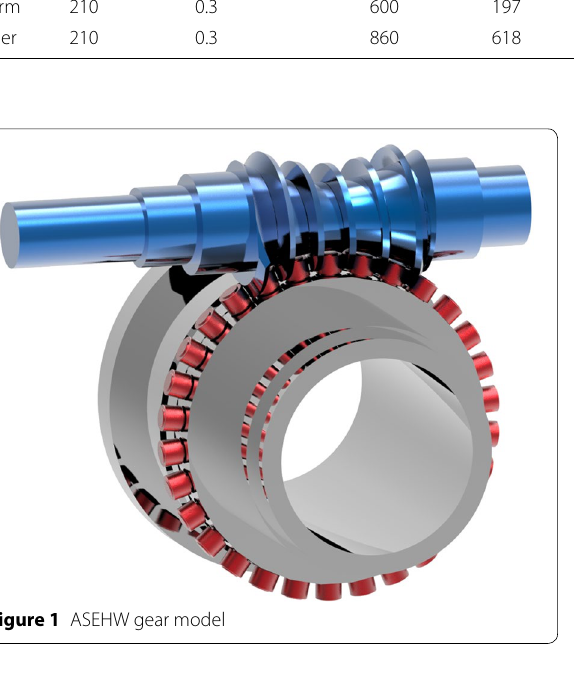
Figure 1 ASEHW gear model